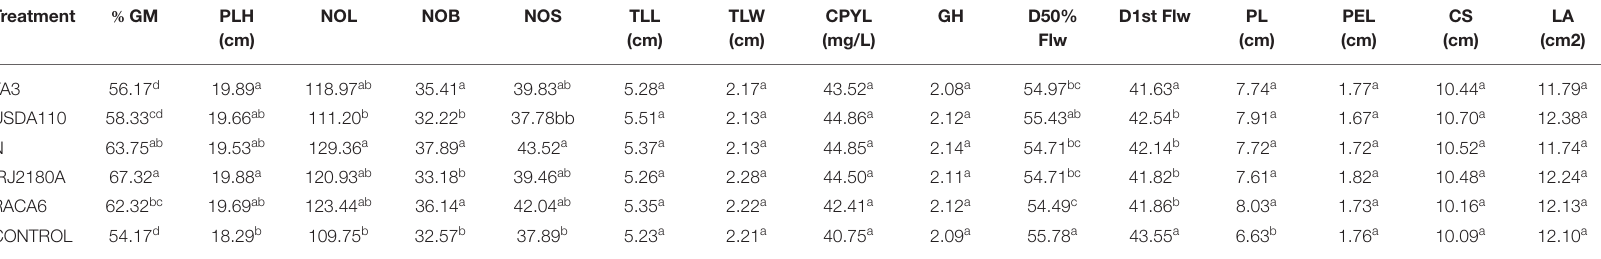
TABLE 2 | Effect of N fertilizer and B. japonicum strains on the percentage of germination at 2 WAP, growth traits of accessions of Bambara groundnut at 7 WAP, and flowering in the first season in Ibadan and Ikenne 2019. Treatment